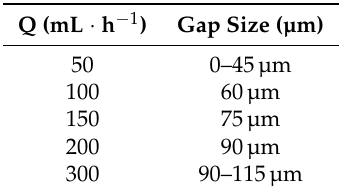
Table 1. Measurement results of the gap sizes between the top of the MNP aggregate at the center and the top wall at different flow rates. At the lowest flow rate only a small part of the MNP aggregate reached the top wall at the center. In all cases the aggregate was thinner at the side walls than at the center. In the Q = 300 mL · h − 1 case the aggregate thinning was more representative. The accuracy of the measurement was estimated to ± 15µm. Q (mL · h − 1